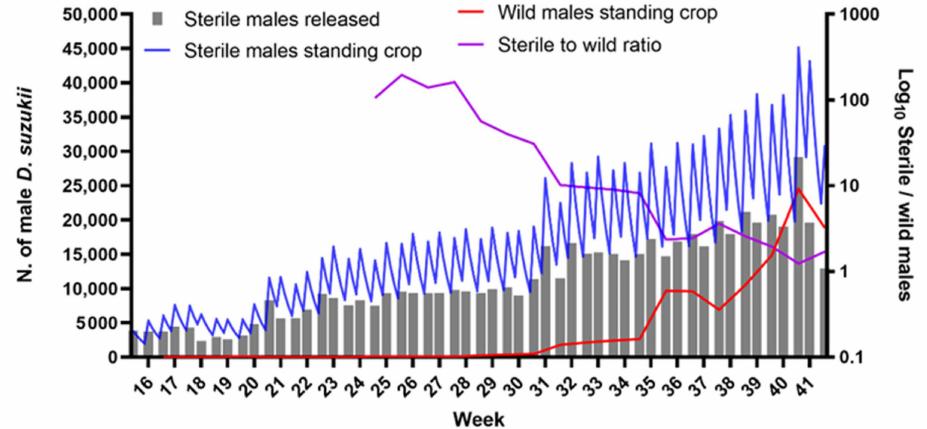
Figure 3. Number of sterile male D. suzukii released (grey), estimated standing crop of sterile (blue line) and wild (red line) male D. suzukii (left y -axis) and the ratio of sterile to wild captures (purple line, right Y -axis) on red sticky traps (red impact sticky board; 10 × 24.5 cm—Russell IPM), each with an attached dry lure (SWD dry lure—Russell IPM) at the SIT-treated site under polytunnels throughout the trial (April–October 2021). Sterile to wild male ratio before week 25 was excluded because no wild males were caught. The y -axis on the right represents the sterile to wild ratio on a log 10